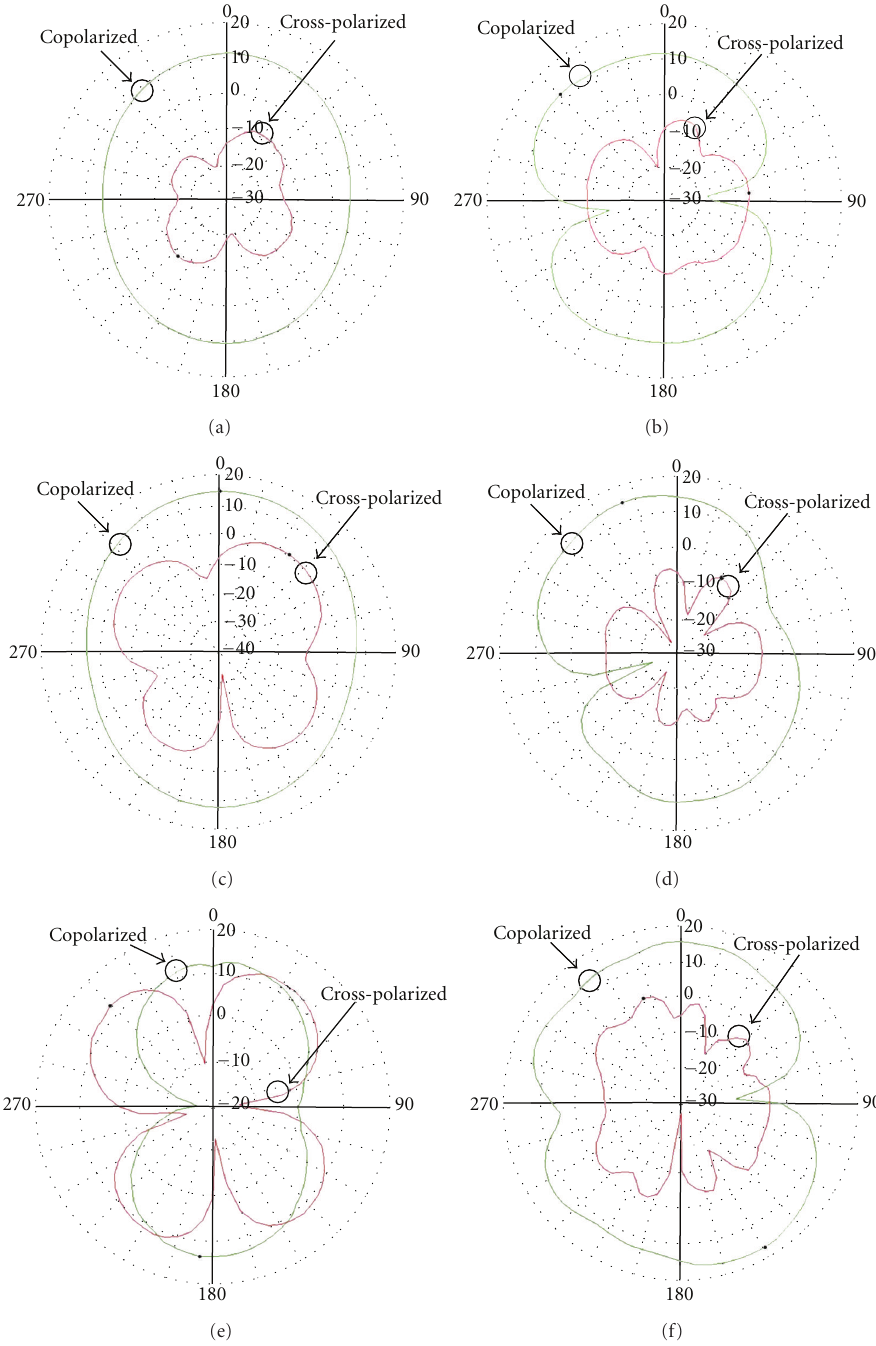
Figure 9: Radiation patterns of hybrid DR antenna at resonant frequency of (a) 2.36 GHz in the xz -plane, (b) 2.36 GHz in the yz -plane (c) 3.88 GHz in the xz -plane, (d) 3.88 GHz in the yz -plane, (e) 5.66 GHz in the xz -plane, and (f) 5.66 GHz in the yz -plane.